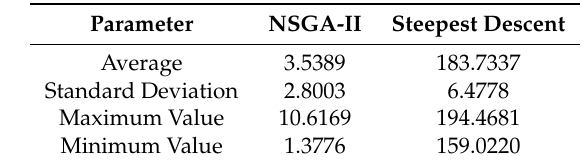
Figure 13. Boxplot of the hypervolume statistics. Table 6. Statistics of execution time per solution (in seconds).